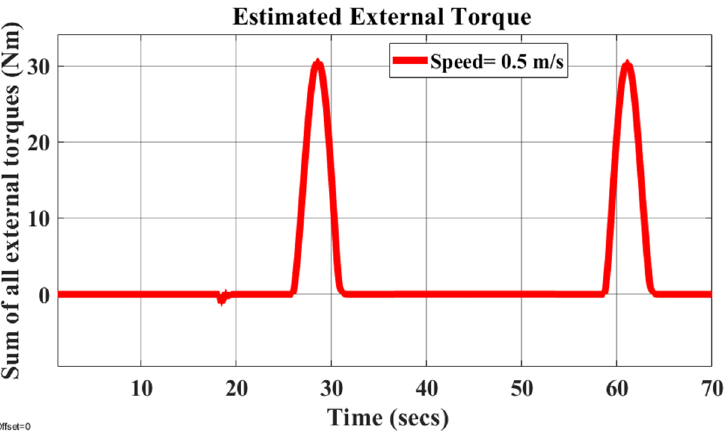
Figure 11. Estimated external torque when collision takes place.